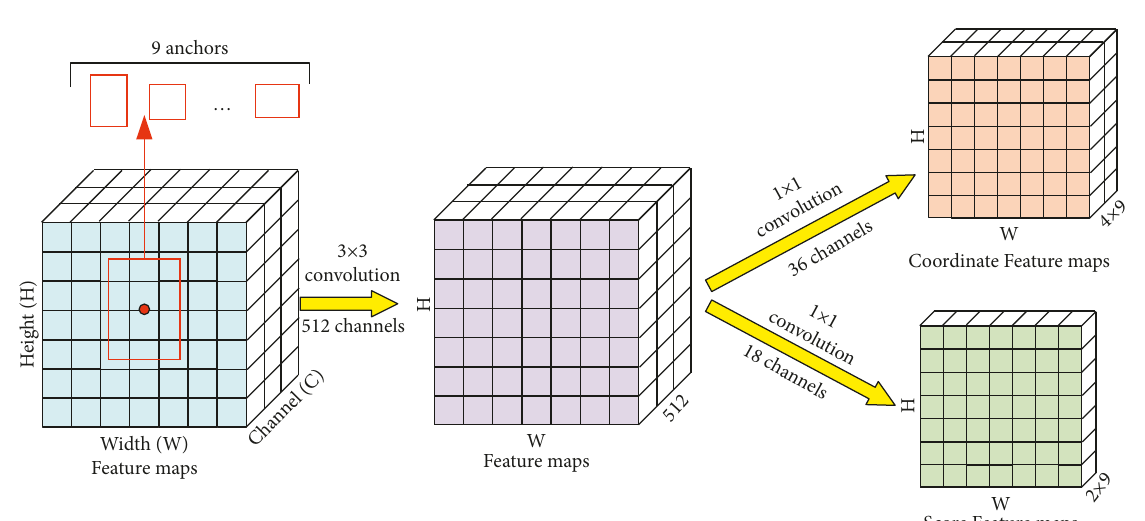
Figure 10: The implementation details of RPN in our detection